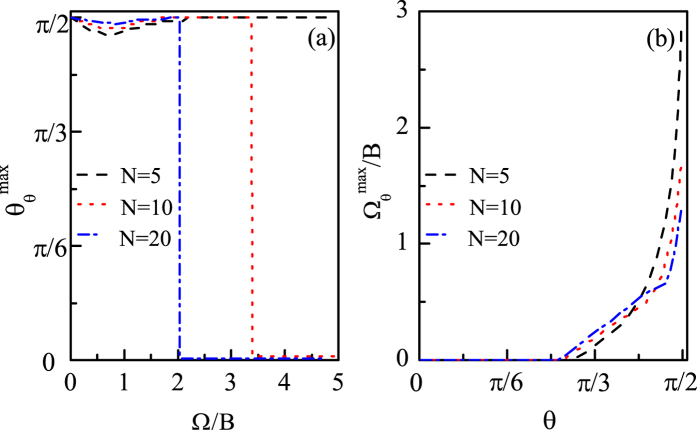
(a)  as a function of Ω for different N (b)  as a function of θ for different N. B = 1 and Γ0 = 0.03B.